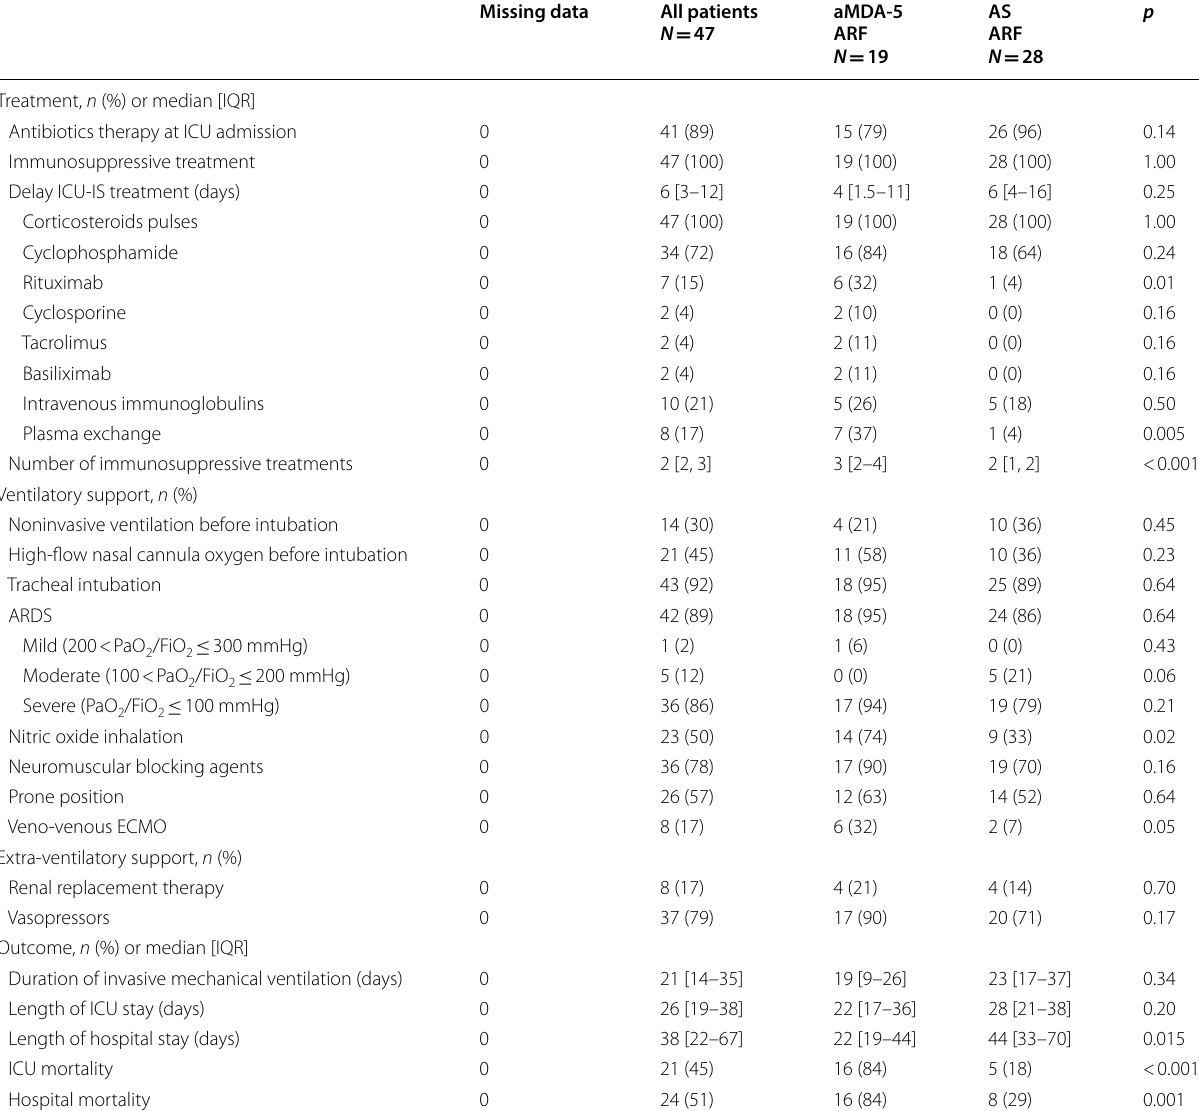
aMDA - 5 anti-MDA-5 antibodies, AS anti-synthetase, ARDS acute respiratory distress syndrome, ARF acute respiratory failure, ECMO extra-corporal membrane oxygenation, ICU intensive care unit, IQR inter-quartile range, IS immunosuppressive treatment